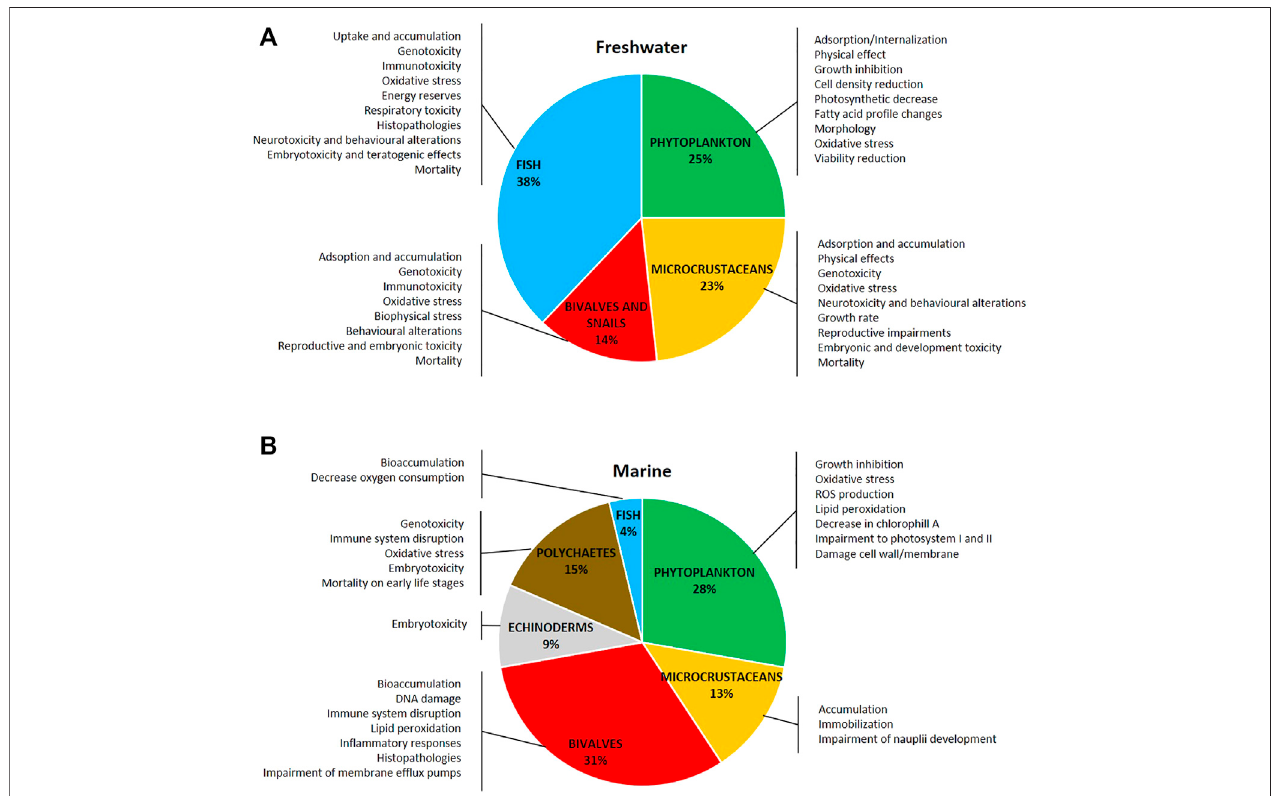
FIGURE3| Distributionoftaxainvestigatedandthemaintoxic effectsofsilvernanoparticleson (A) freshwaterand (B) marineorganisms.Theliterature usedrefers to research articles cited in the text (freshwater: 116 articles; marine: 54 articles).